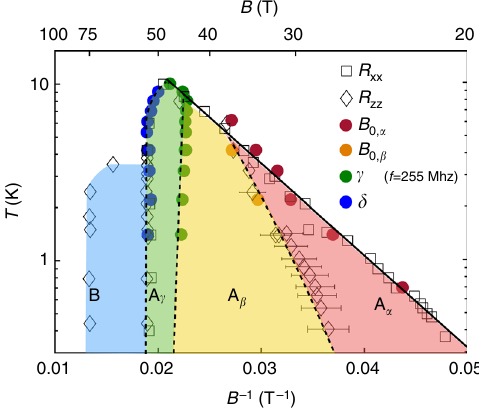
Fig. 2 ( B − 1 , log( T )) phase diagram of graphite. Two main domes labeled dome A and dome B are found as a function of magnetic fi eld. Dome A consists of a sequence of electronic phases labeled A α , β , γ , δ separated by thermodynamic phase transition lines respectively labeled α , β , γ , and δ , as shown in Fig. 1. In this work we determined those transition lines with ultrasound measurements (full circles) and transport measurements ( R xx and R zz in black open squares and diamonds, respectively). The fi eld scales B B α and β 0, α and 0, β correspond to the ultrasound anomaly at the transitions extrapolated at zero frequency using the Landau-Khalatnikov formula (see text). Values reported for the γ -transition are taken at 255 MHz, and the δ transition shows a negligible frequency dependence. The black line associated with the α transition corresponds to the behavior expected from a BCS-like description of the DW transition 8 . Dotted lines are guides to the eye for the β , γ , and δ -transition lines. The boundaries of dome B have been determined previously using R zz 25 . The error bars of B 0, β have been estimated by measurements of R zz in fi ve different